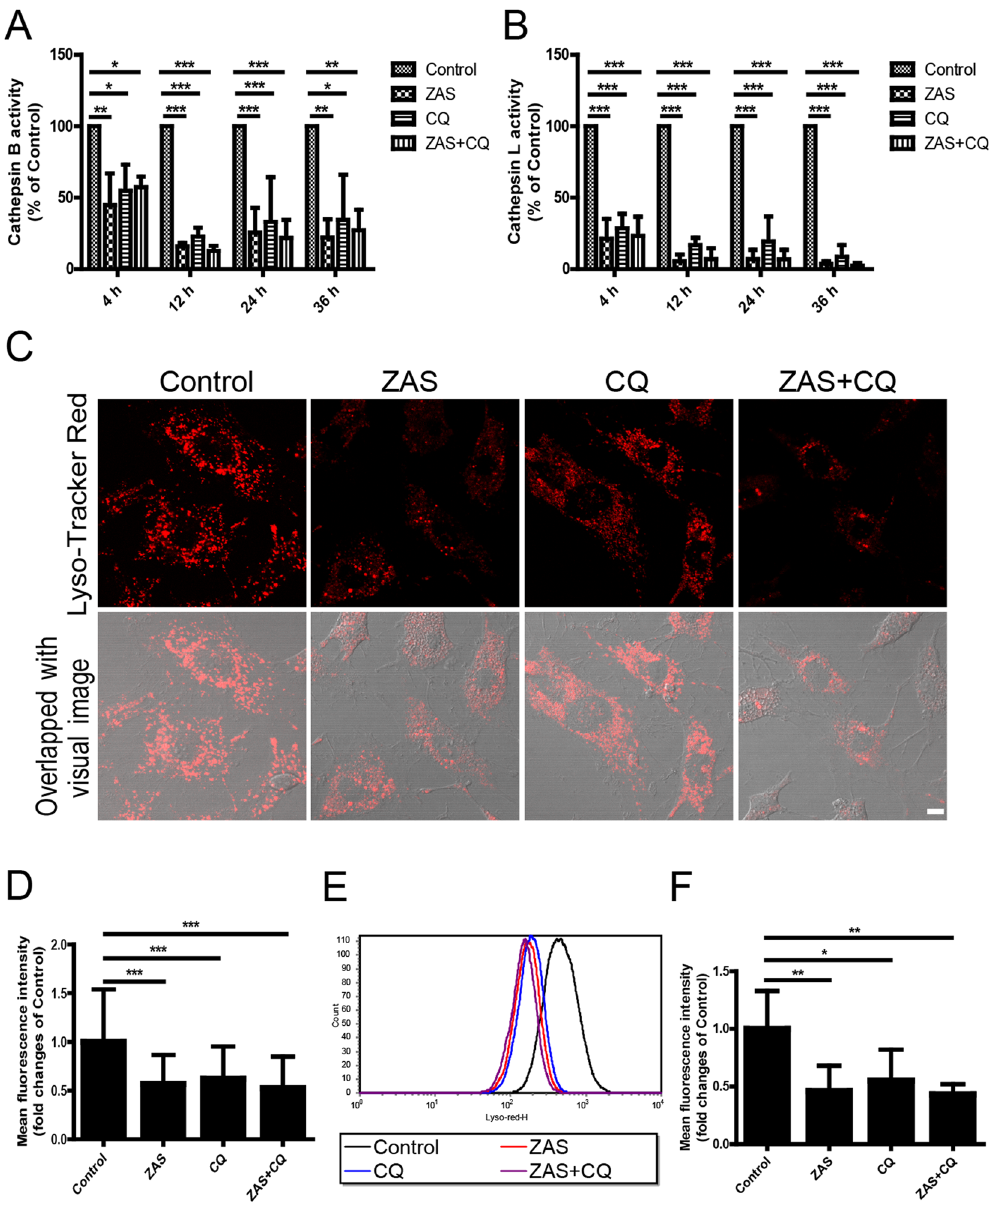
Figure 8. Zymosan activation serum (ZAS) induces decreased enzymatic activity and impaired acidification of lysosomes in podocytes. ( A , B ) Markedly decreased proteolytic activity of cathepsin B and cathepsin L was observed in podocytes after exposure to ZAS with or without chloroquine (CQ, 10 μ M) from 4 h to 36 h using a fluorescence-based assay kit. ( C , D ) Impaired acidification of lysosomes was found by staining with Lyso- Tracker Red, an indicator of acidic intracellular compartments, in podocytes after exposure to ZAS with or without CQ (10 μ M) for 4 h. Images were obtained using a confocal microscope and the mean fluorescent intensity of Lyso-Tracker Red in podocytes was quantified using Leica confocal software. Scale bar, 10 μ m. ( E , F ) Representative histogram obtained from Lyso-Tracker Red staining followed by flow cytometric analysis indicated the decreased Lyso-Tracker Red signals and mean fluorescent intensity in podocytes after exposure to ZAS with or without CQ (10 μ M) for 4 h. The data represent the fold-change relative to the control cells and are shown as mean ± SD. * P < 0.05, ** P < 0.01, *** P <